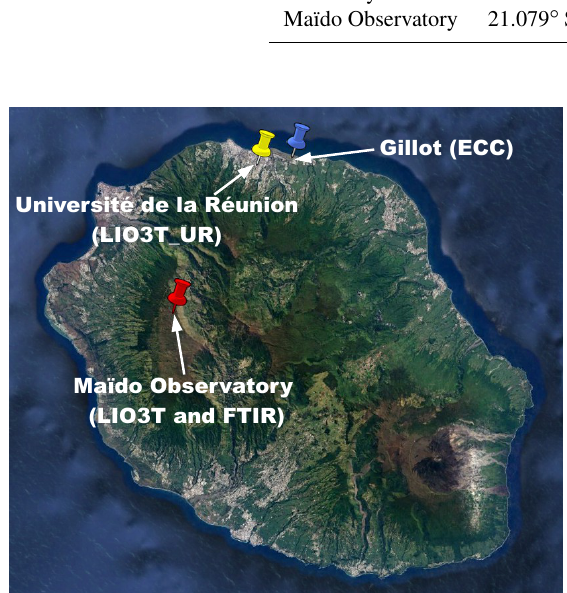
Figure 1. Map showing the locations of the different measurement sites (Maïdo Observatory, Gillot and the university on Reunion Is- land) and instruments (LIO3T UR , ECC, FTIR and LIO3T) used in this